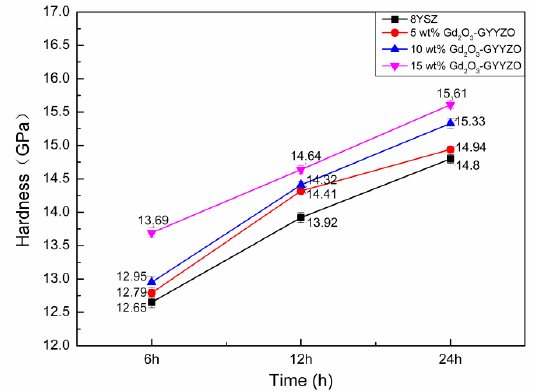
Figure 6. Hardness of the sintered bulks.